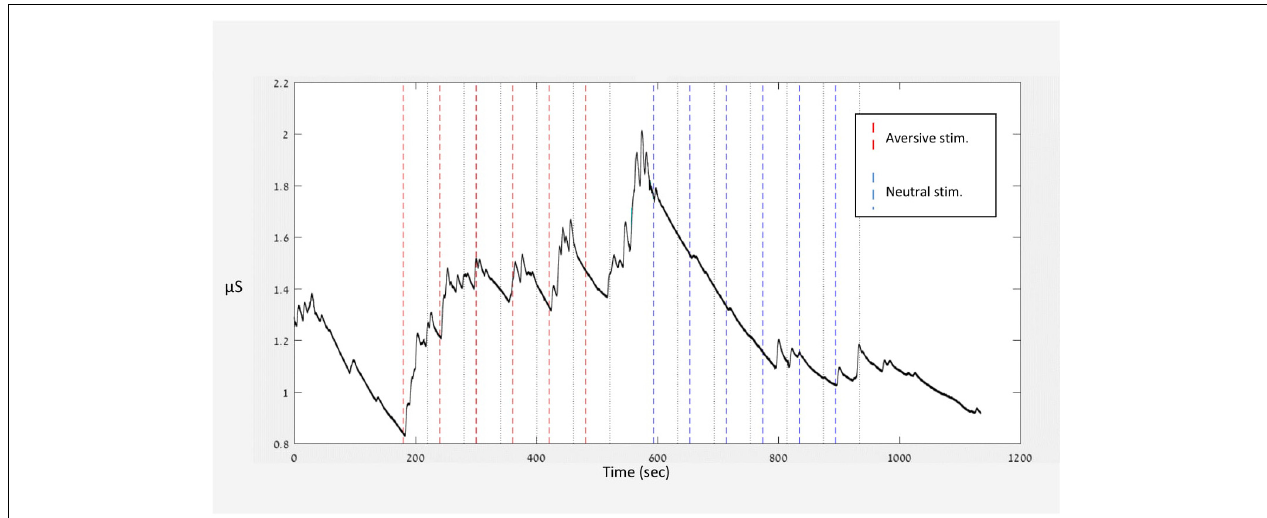
FIGURE 2 | Typical recordings (raw data) of a single